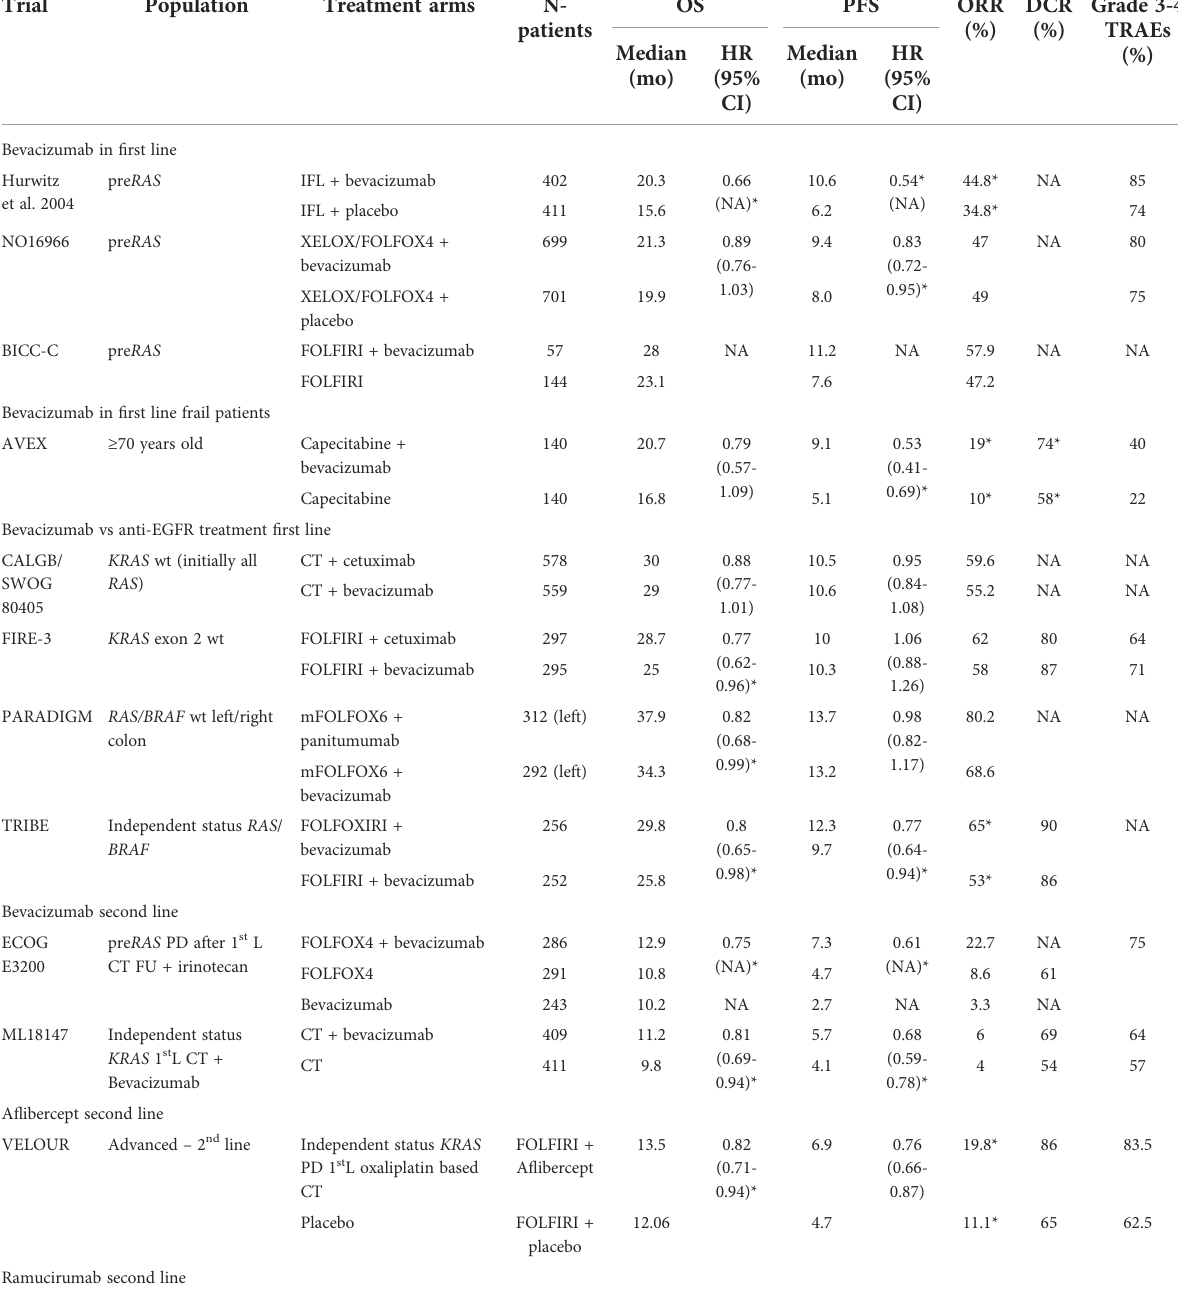
TABLE 1 Overview of selected phase III trials testing anti-angiogenic agents in